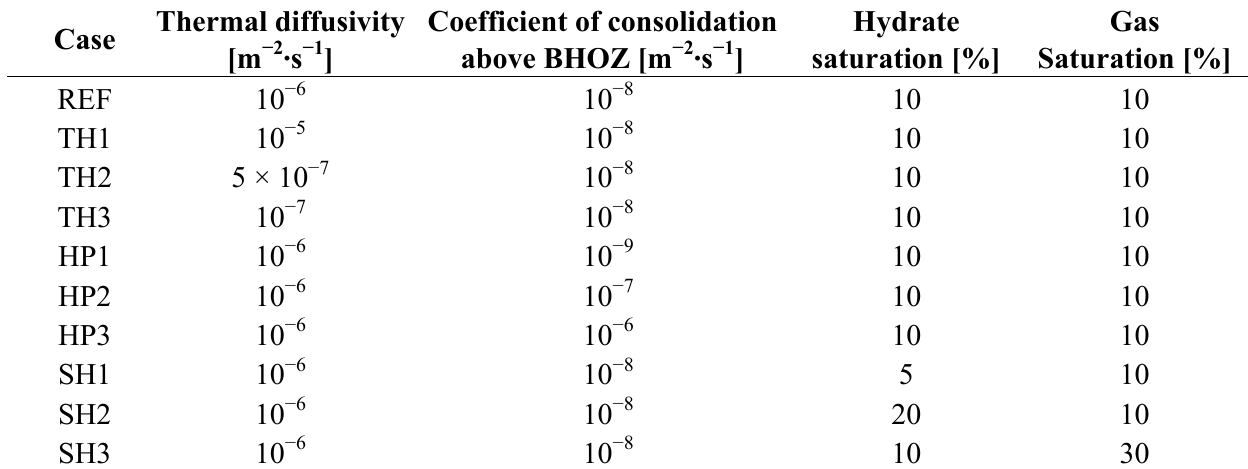
Table 3. Summary of Simulated